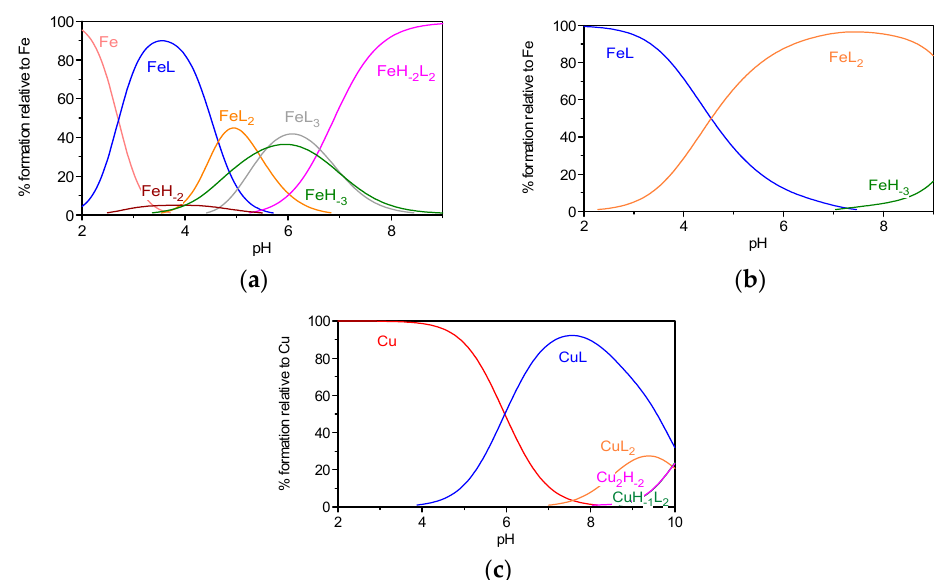
Figure 6. Species distribution curves for the systems: (a) Fe 3+ / FA , 1:3 ( C L = 5 × 10 − 4 M); (b) Fe 3+ / 1a , 1:2 ( C L = 4 × 10 − 5 M); (c) Cu 2+ / 1d 1:2 ( C L = 4 × 10 − 5 M).